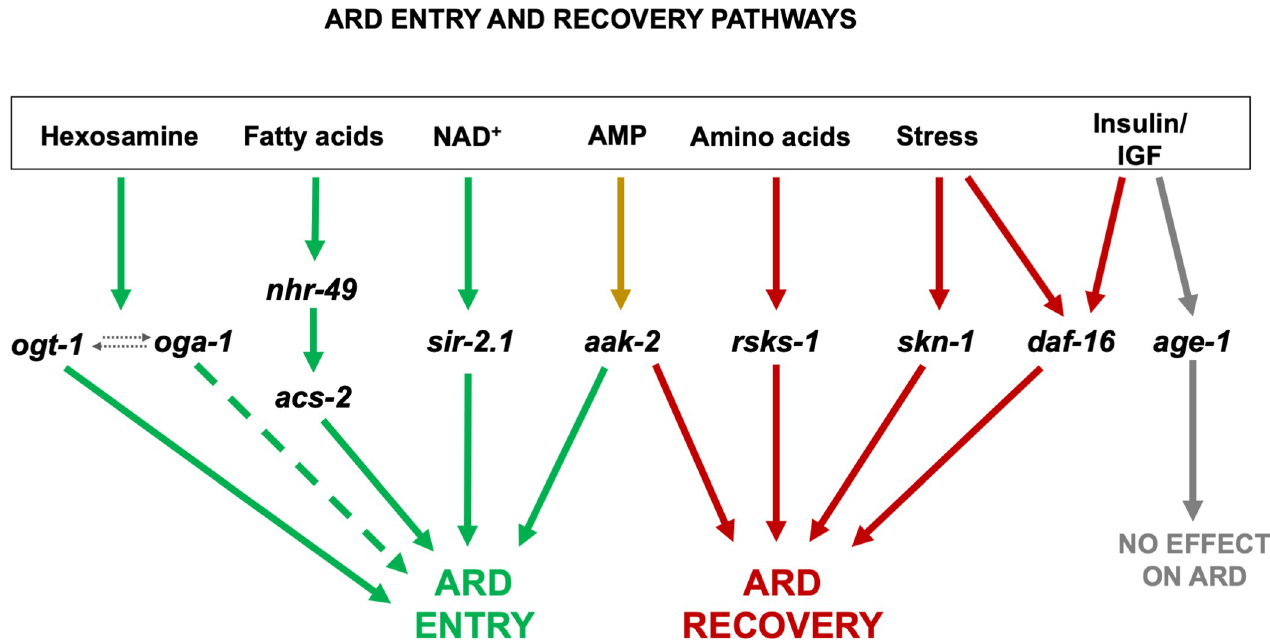
Fig 6. Model of genetic modifiers of ARD phases. Specific nutrient-sensing pathways contribute to ARD entry and exit. The initial sensing and dissemination of the signal to enter ARD (green pathways) includes genes encoding proteins involved in O -GlcNAc cycling ( ogt-1 , oga-1 , with dotted arrows showing their biochemical interaction), genes that regulate fatty acid metabolism ( nhr-49 , acs-2 ) and sirtuins ( sir-2 . 1 ). The dashed green line indicates an allele-specific effect on ARD entry. Energy sensing, mediated by the product of aak-2 , uniquely acts in both ARD initiation and recovery (yellow pathway). The two members of the insulin/IGF signaling pathway tested in this study showed differing results with age-1 not affecting ARD (grey pathway), while the downstream daf-16 affected recovery (red pathway). ARD recovery additionally relies on the TOR pathway ( rsks-1 ), which may also interact with daf-16 . Stress signaling influences ARD recovery as well, with skn-1 playing a minor role, and another possible pathway interacting with daf-16 .